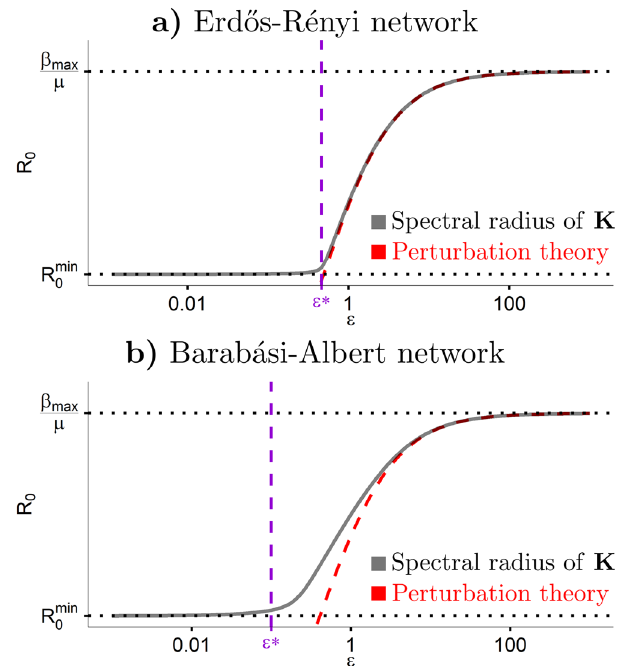
Fig. 2 Basic reproduction number R 0 of the whole metapopulation network as a function of the time scale ratio ϵ . The two panels show the behavior of a ( a ) Erd ő s-Rényi and a ( b ) Barabási – Albert metapopulation network, models for homogeneous and scale-free connectivity of spatial patches, respectively. The solid gray curve indicates the values of R 0 found numerically by solving the eigenvalue problem for the next-generation matrix K , whereas the red line corresponds to the value analytically derived in Eq. (8) by using perturbation theory. The approximation is excellent for the homogeneous connectivity, whereas in the case of the heterogenous one it works only for ϵ > 1. The vertical dashed violet line indicates the position of the metacritical point ϵ ⋆ obtained analytically, that separates the regime in which R 0 stays constant and equal to its minimum value R min (see 0 Eq. (10)) from the regime in which it start growing. Finally the horizontal dotted black lines correspond to the lower bound on R 0 , which in this case ¼ 1, and the upper bound β = μ ¼ 2, where μ = 2 is the recovery is R min 0 max ¼ 4 is the maximum transmission rate among those in the rate and β max